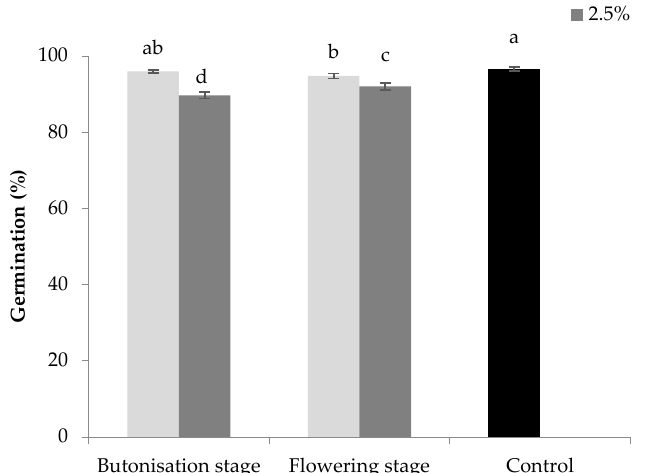
Figure 1. Allelopathic effect of water extracts from sunflower leaves collected in the butonisation and